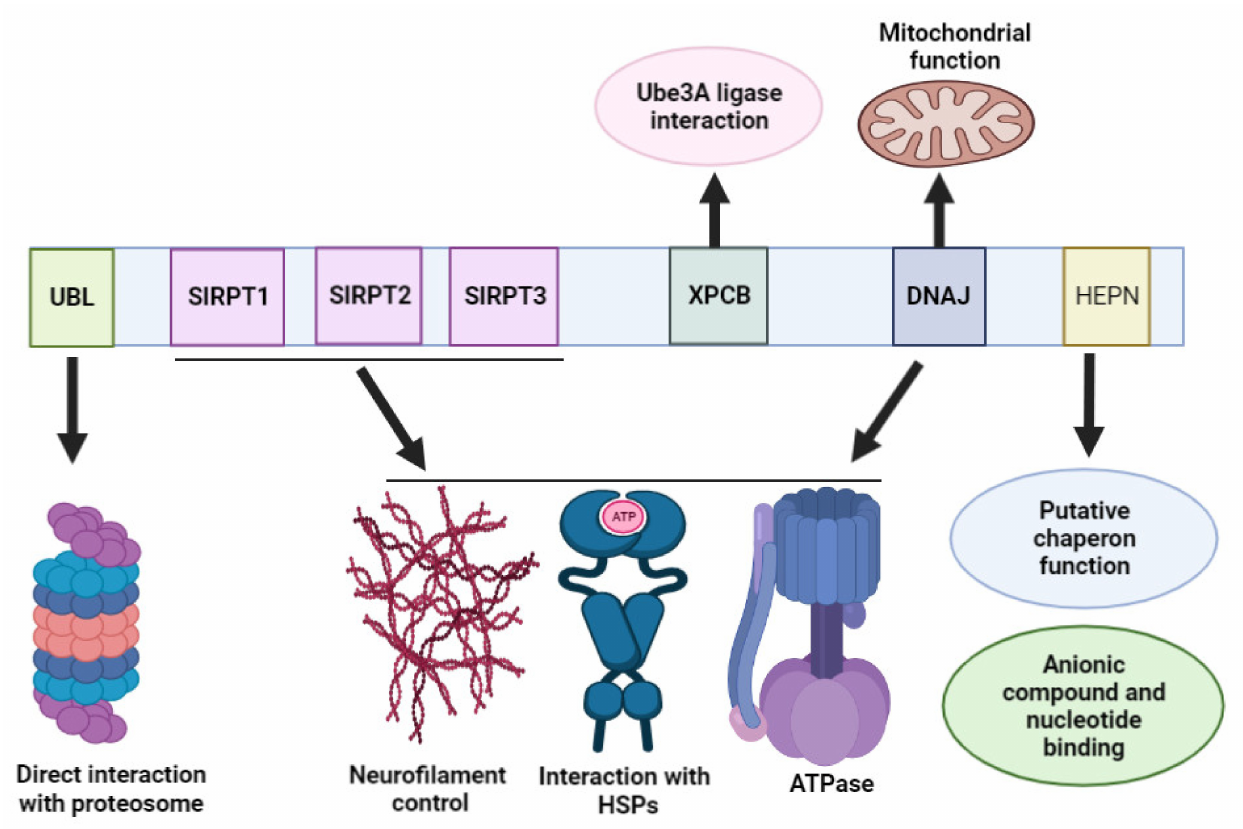
Figure 1. Schematic showing the domain structure of the of sacsin protein and the potential functions of different